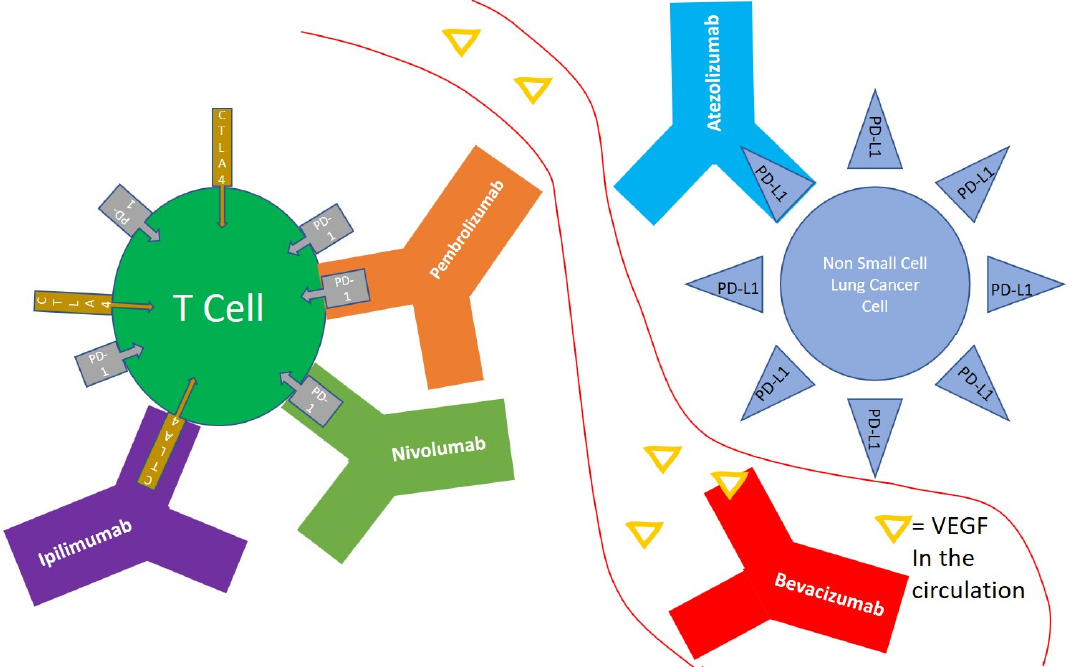
Figure 1. Non-small cell lung cancer (NSCLC) cells expressing programmed death-ligand 1 (PD-L1) could interact with programmed death receptor 1 (PD-1) expressed on the surface of T cells, and result in decreased tumor cell kill by the immune system. Atezolizumab is an anti PD-L1 monoclonal antibody. Nivolumab and Pembrolizumab are anti PD-1 monoclonal antibodies. Ipilimumab is a monoclonal antibody that targets Cytotoxic T-lymphocyte-associated protein 4 (CTLA-4) on the surface of T cells. Bevacizumab is a monoclonal antibody that targets Vascular Endothelial Growth Factor (VEGF) in the circulation and functions as an angiogenesis inhibitor.